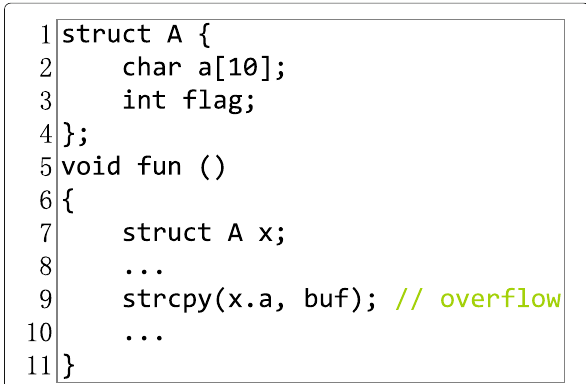
Fig. 1 An example of memory access